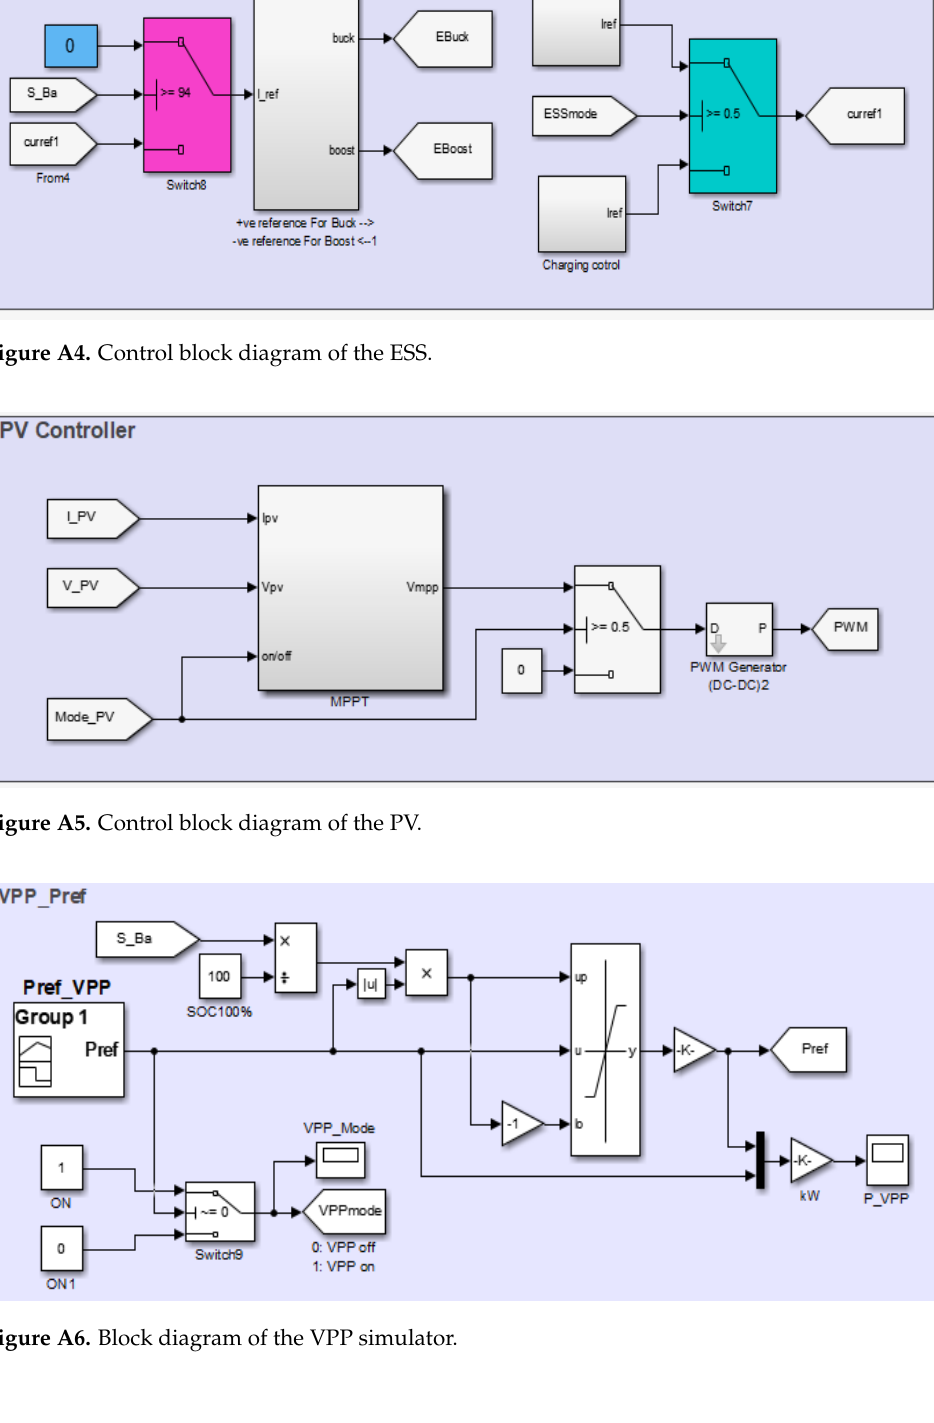
Figure A3. Bidirectional DC/DC converter.